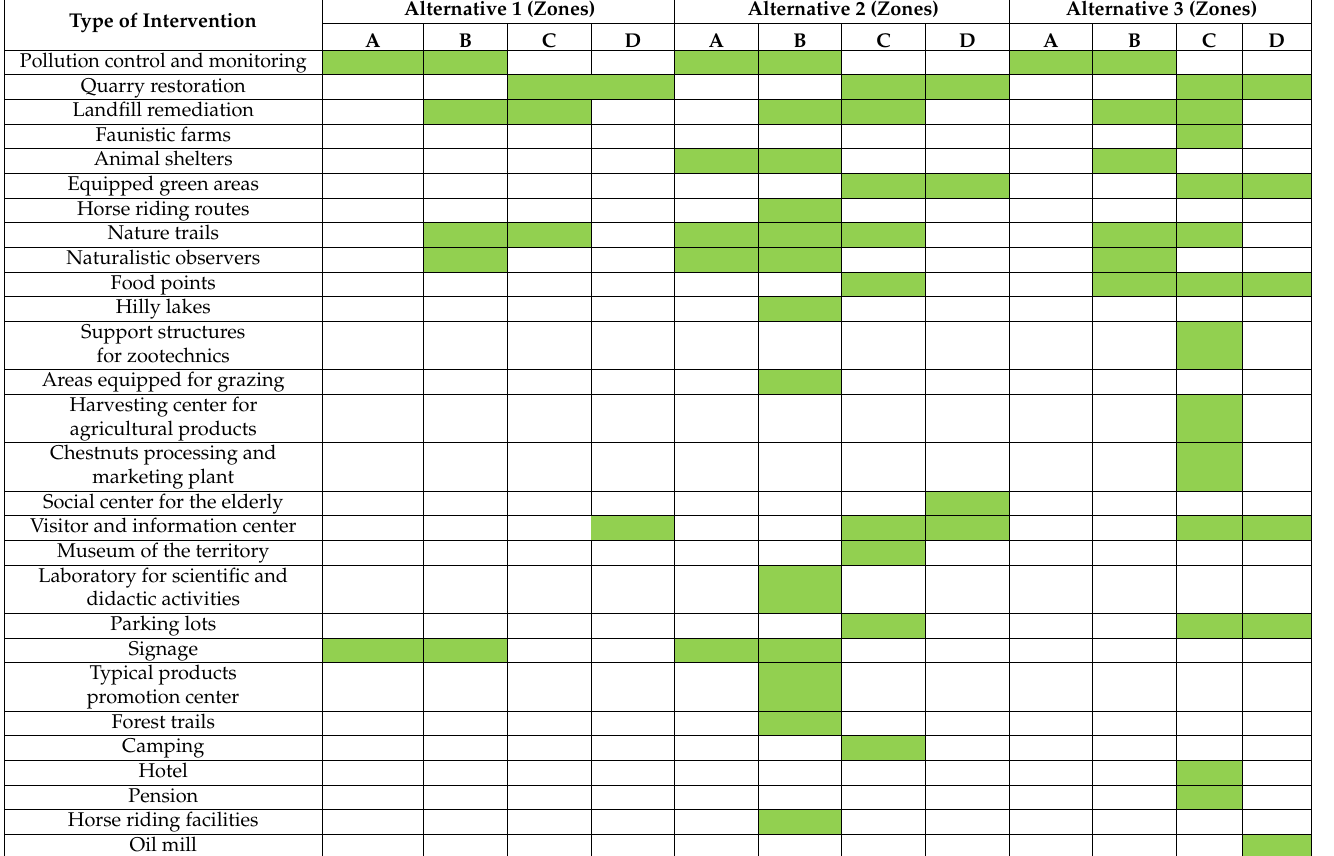
Table 8. Summary of design alternatives: green cells represent the possibility of admitting the intervention in the area. Type of